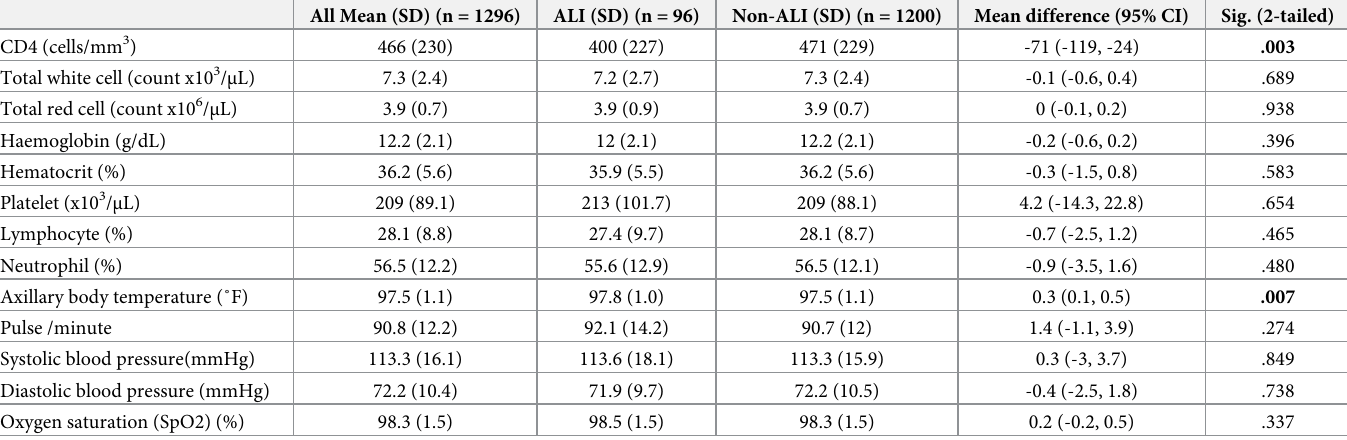
Table 1. Comparison of baseline clinical parameters and haematology results in 1,296 people living with HIV (PLHIV) with and without asymptomatic Leishmania infection (ALI) in Bihar, India.